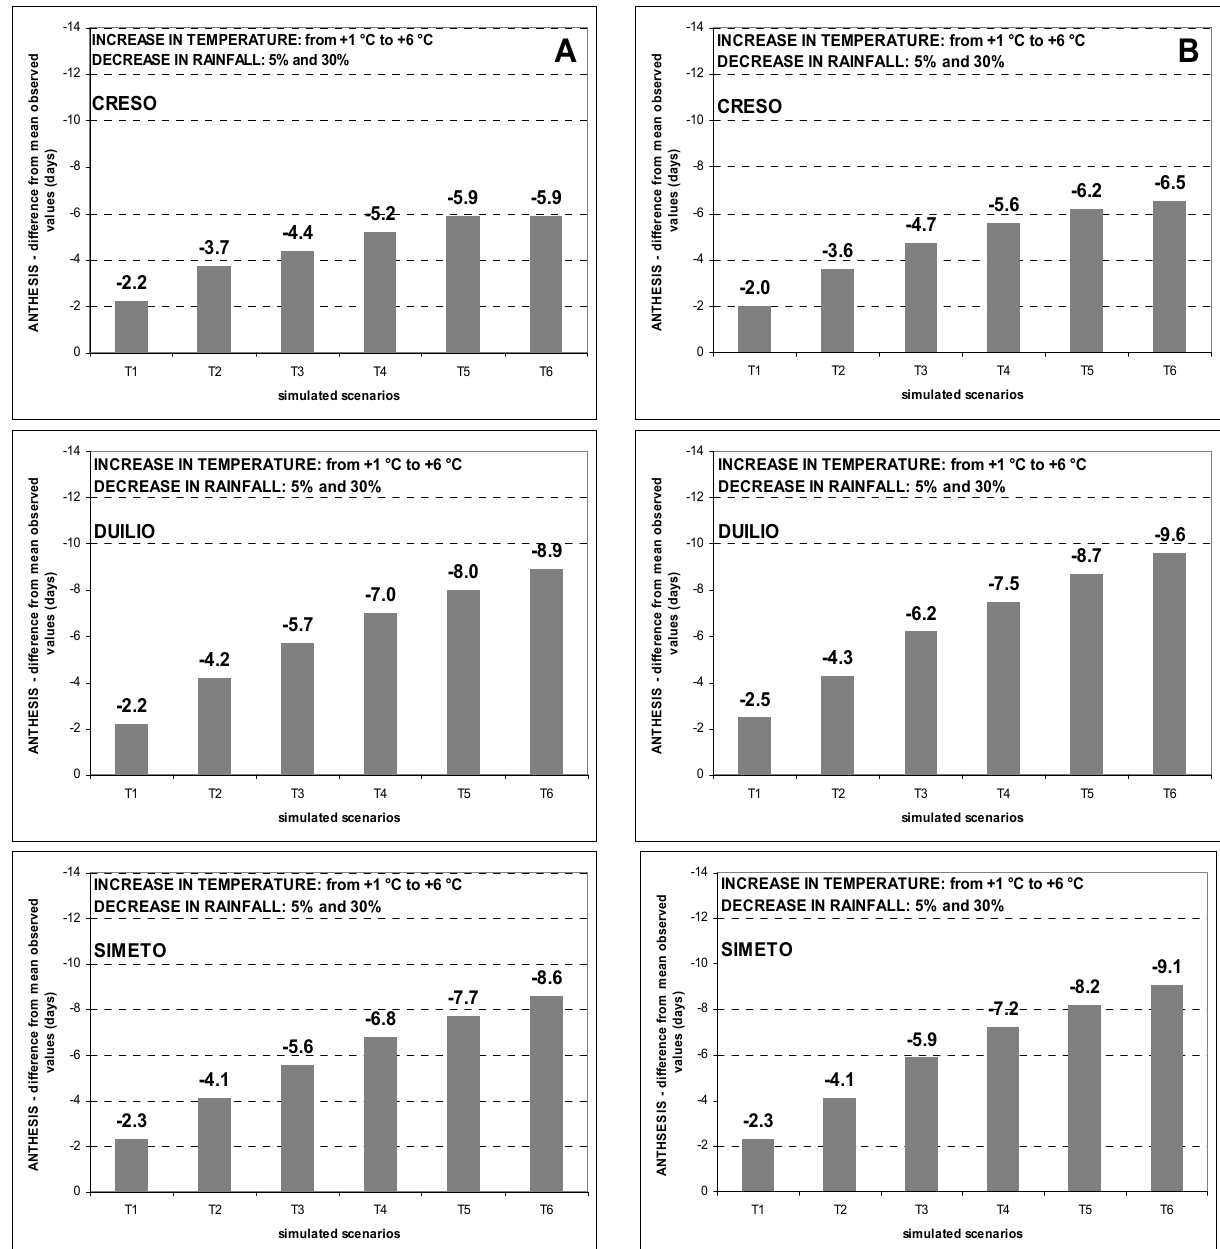
Figure 8. Reduction (in days) of crop growing cycle (from sowing to anthesis) over the period 1990– 2004 at Benatzu ( A ) and the period 1989–2004 at Ussana ( B ) for climate change scenarios characterized by increasing temperature (from +1 °C to +6 °C) and rainfall reduction by 5% and 30%. Based on the greater overall shortening effect at Ussana (medium-low fertility soil) than at Benatzu (high-fertility soil), soil fertility seems to play a remarkable role in reducing the growth duration of durum wheat. In addition, the difference between simulated and observed values increases moving from scenario T1 (temperature increase: +1 °C) to scenario T6 (temperature increase: +6 °C). Examining this shortening effect on each variety, Creso showed a more limited reduction at both sites when compared to the early genotypes Duilio and Simeto. Table 4 summarizes the simulated impacts of two climate change scenarios (T1_R5 and T6_R30) on grain production and phenology of durum wheat using the CERES-Wheat crop model on three cultivars and two experimental sites.